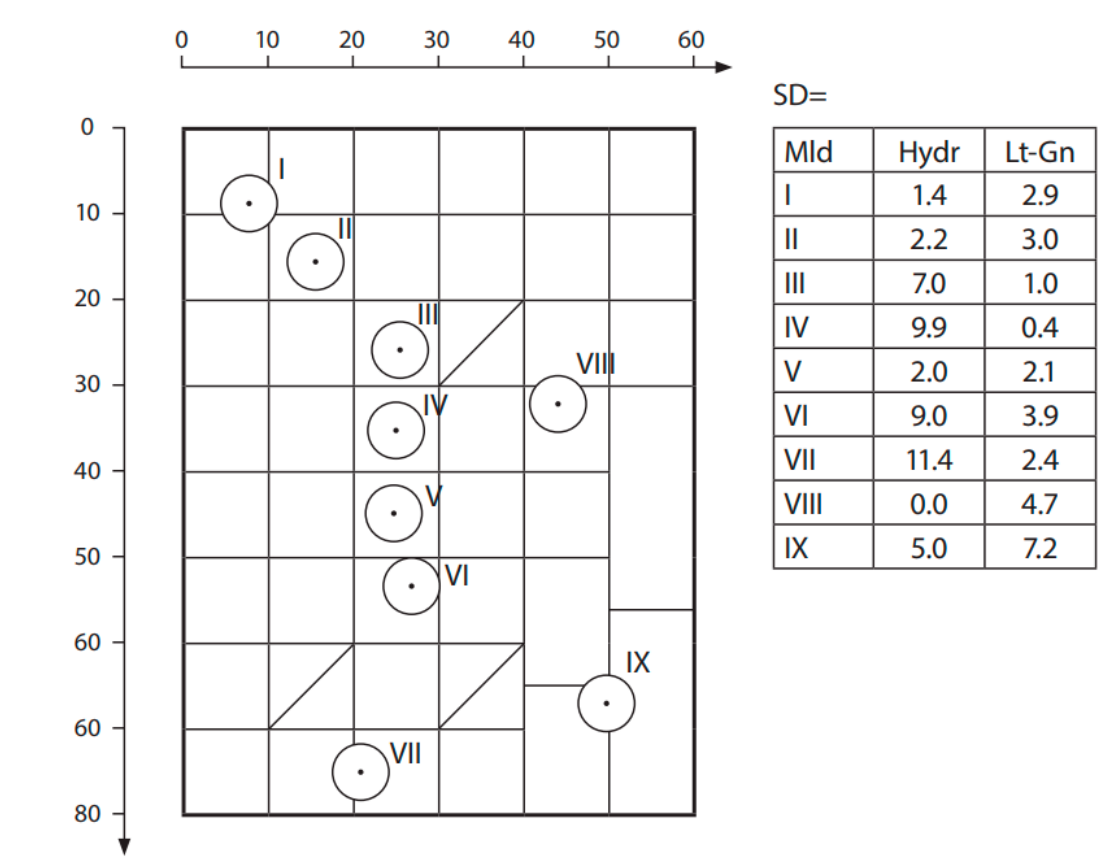
Figure 2. Location of studied soil groups on a mineral soils’ matrix table. The O indicates the positions of the soil groups on the matrix table; on right side are the standard deviations of soil group mean positions by moisture (Hydr) and litho-genetic (Lt-Gn) scalars.